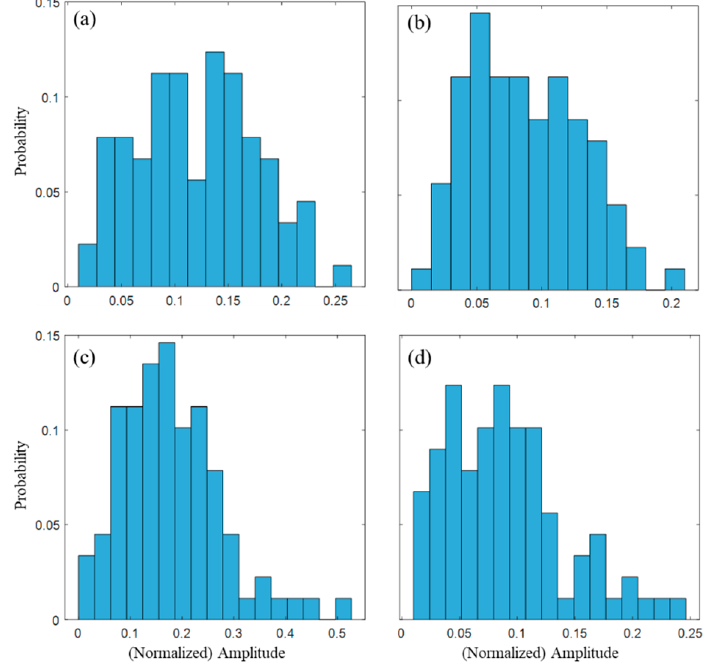
Figure 1. Distribution of amplitudes for ( a ) 24 Hz, ( b ) 29.7 Hz, ( c ) 19.3 Hz, and ( d ) 27.7 Hz. The amplitude was normalized by the signal power.